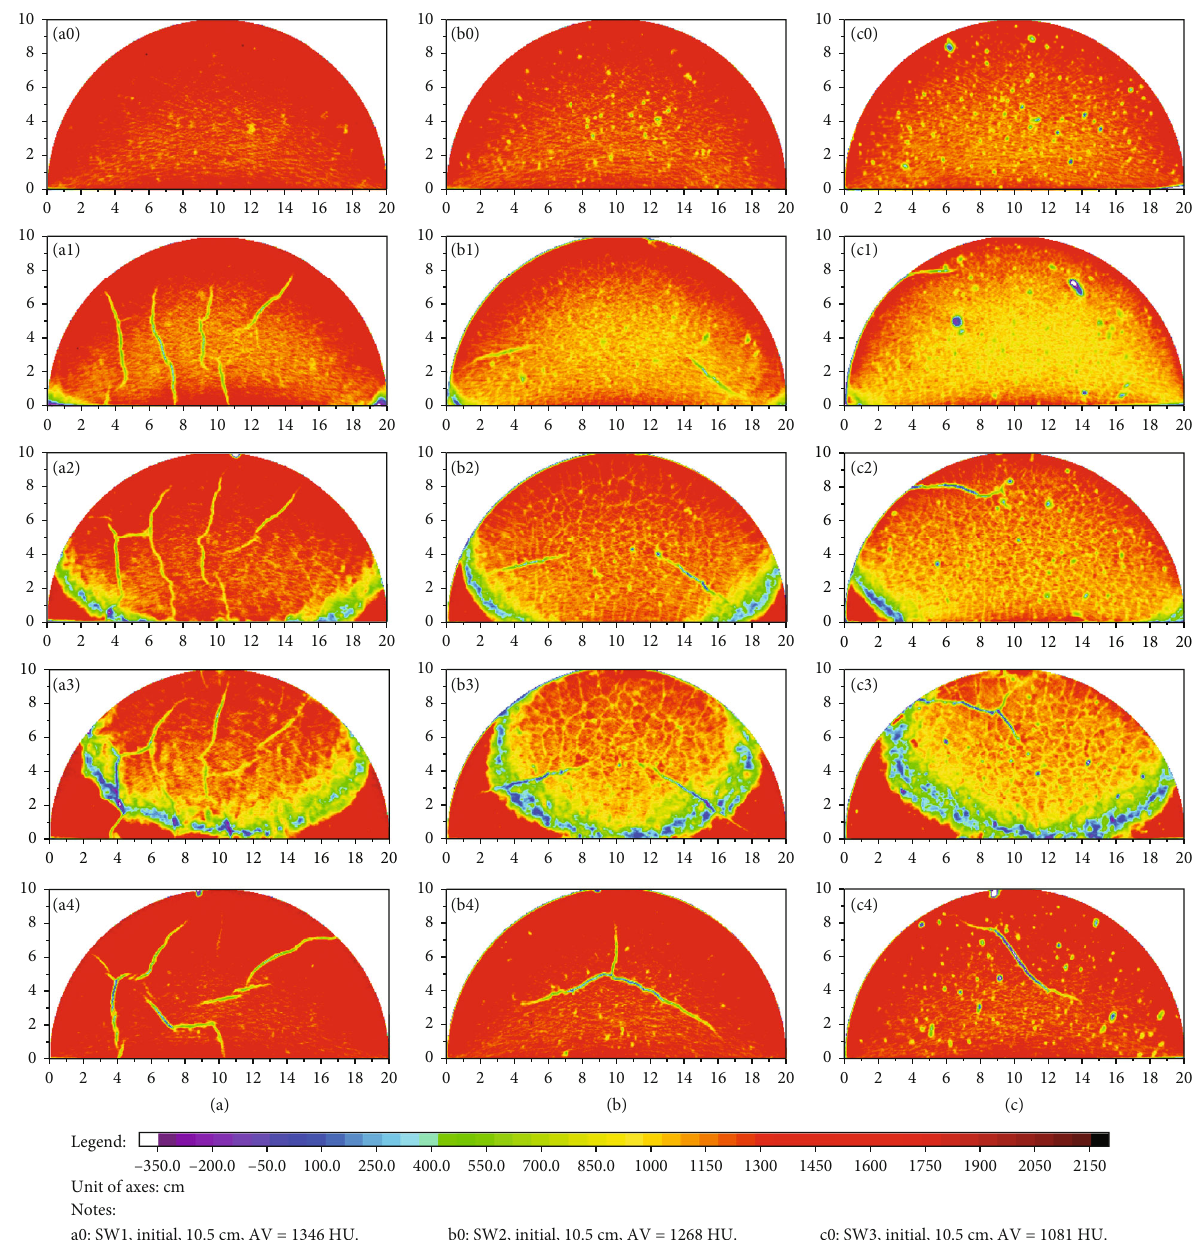
Figure 7: CT value distribution images of the samples SW1, SW2, and